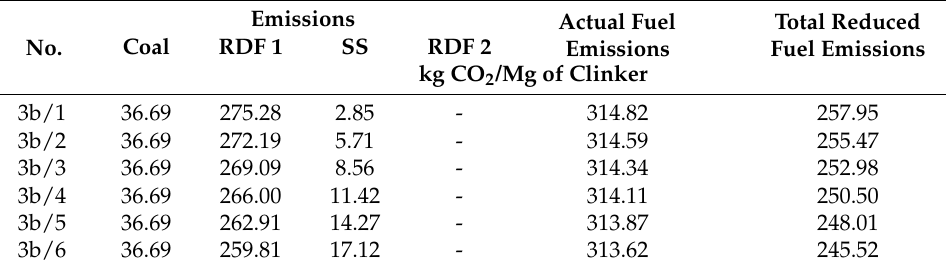
Table 8. The CO 2 emissions balance of blends of coal with RDF 1-SS (3b—three components).